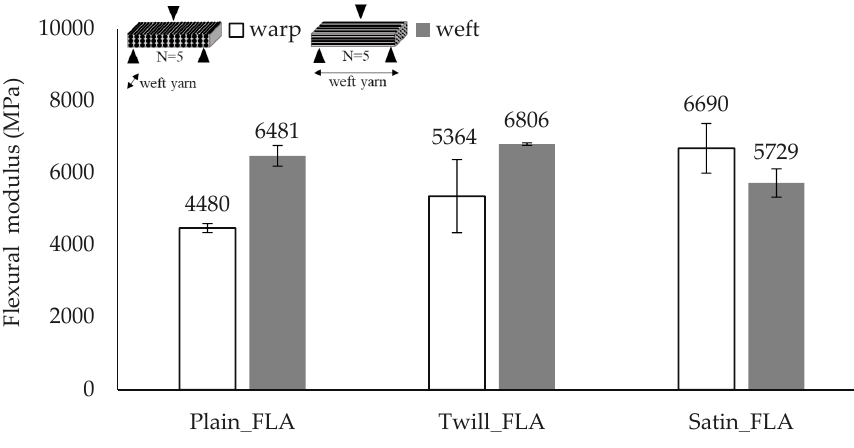
Figure 6. Flexural modulus of flax composites.